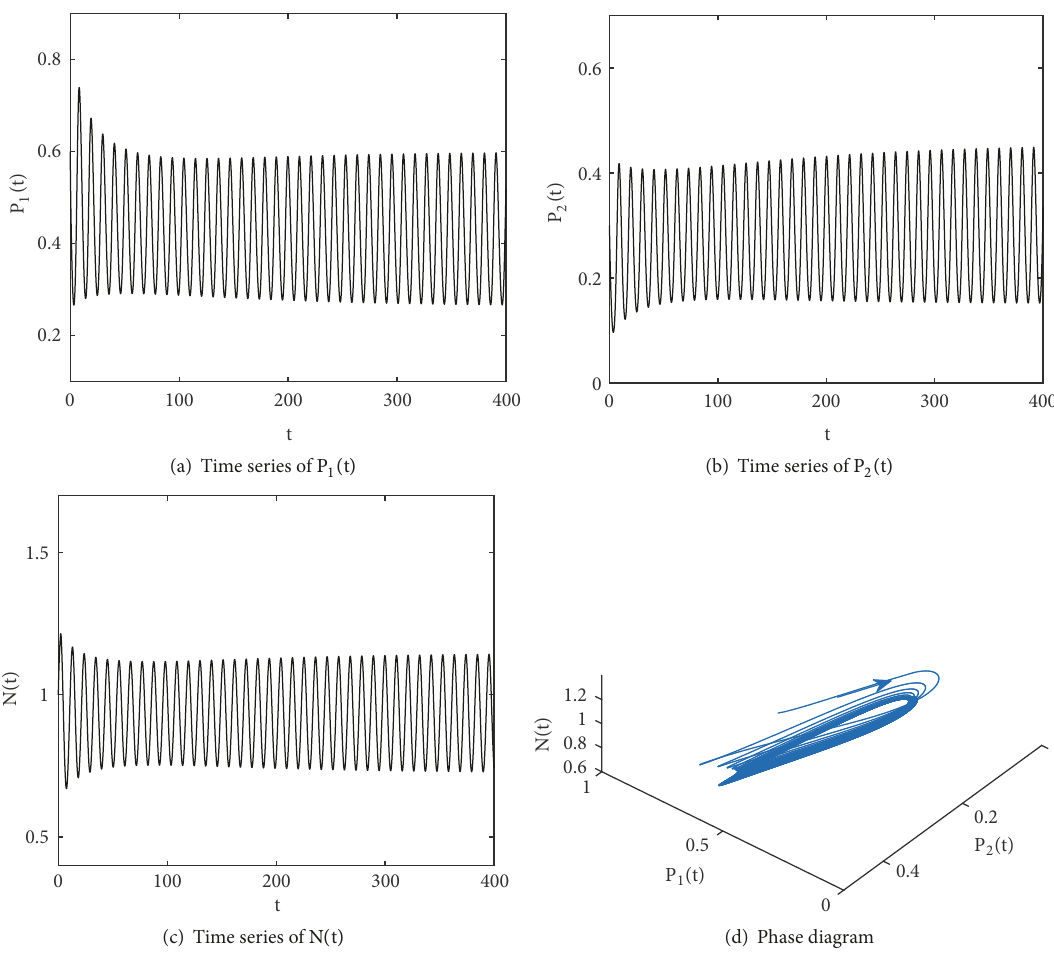
Figure 2: 𝐸 ∗ of system (25) is unstable by choosing 𝜍 = 2.1 > 𝜍 0 .